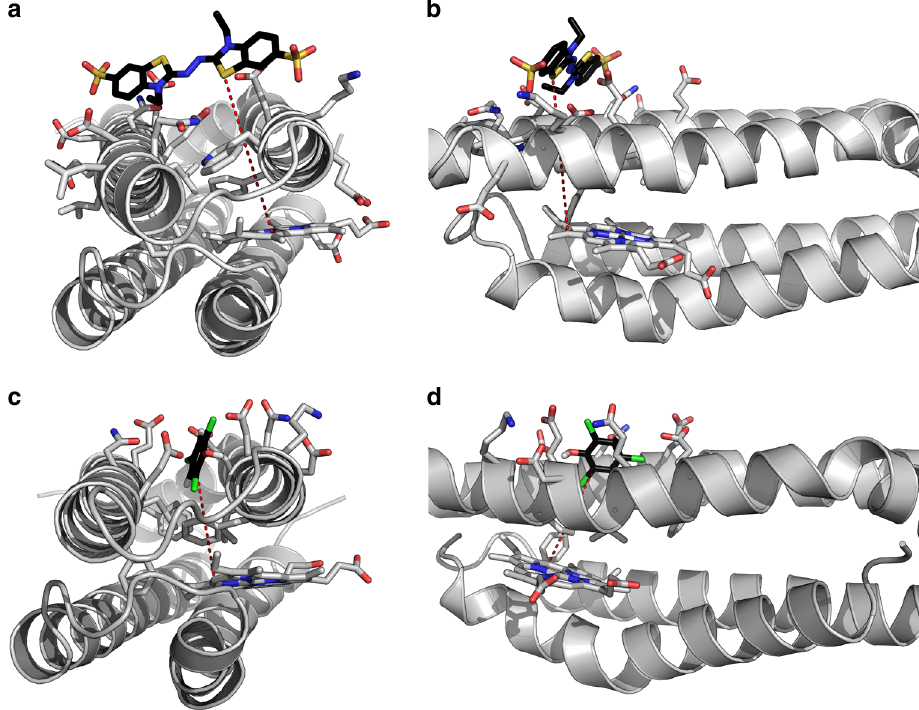
Fig. 5 Computational scanning for substrate – C45 interactions. a , b Single snapshot from an MD simulation of lowest energy ABTS-binding site on the C45 surface derived from BUDE. c , d Single snapshot from MD simulation of lowest energy TCP-binding site on the C45 surface derived from BUDE. The carbons of the substrates are colored black for